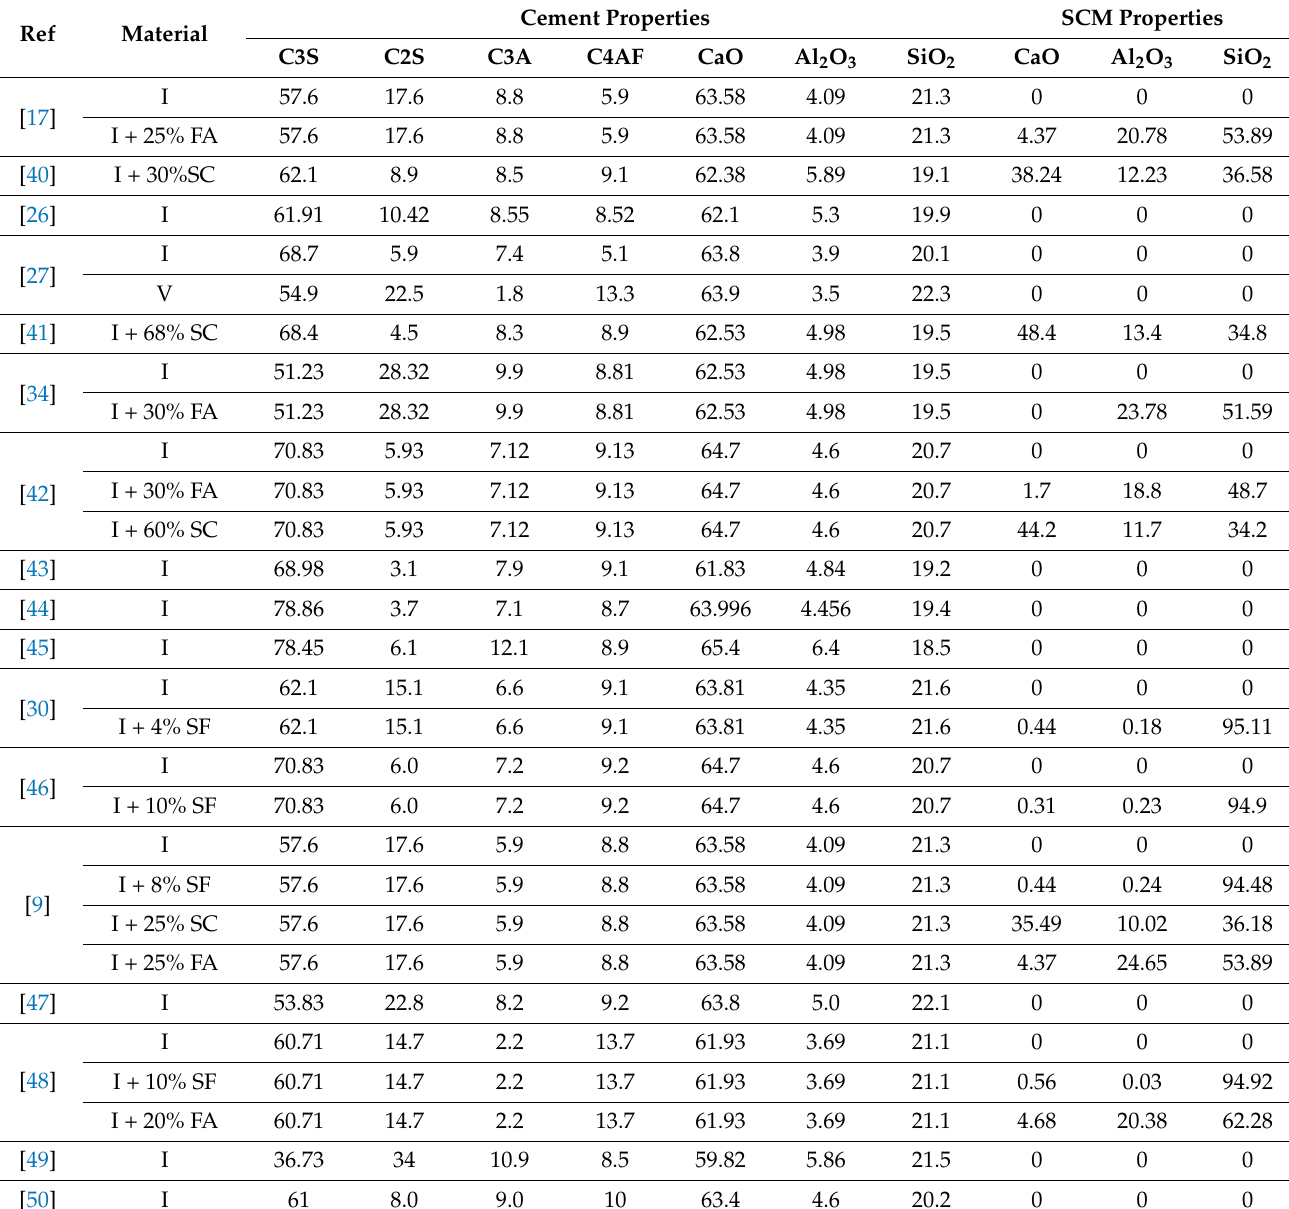
Table 4. Experimental results from the literature.